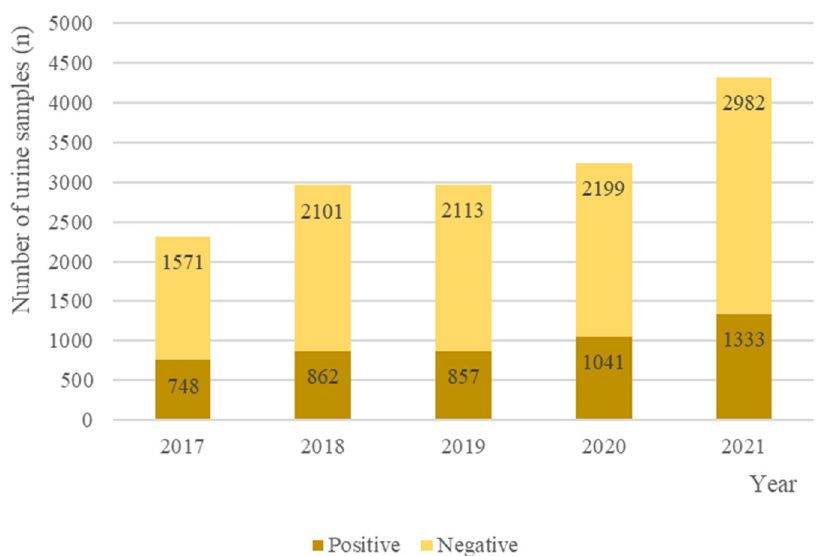
Figure 1. Negative and positive cultures grown from the 17472 urine samples from dogs and cats submitted to the INNO veterinary laboratory between 2017 and 2021.